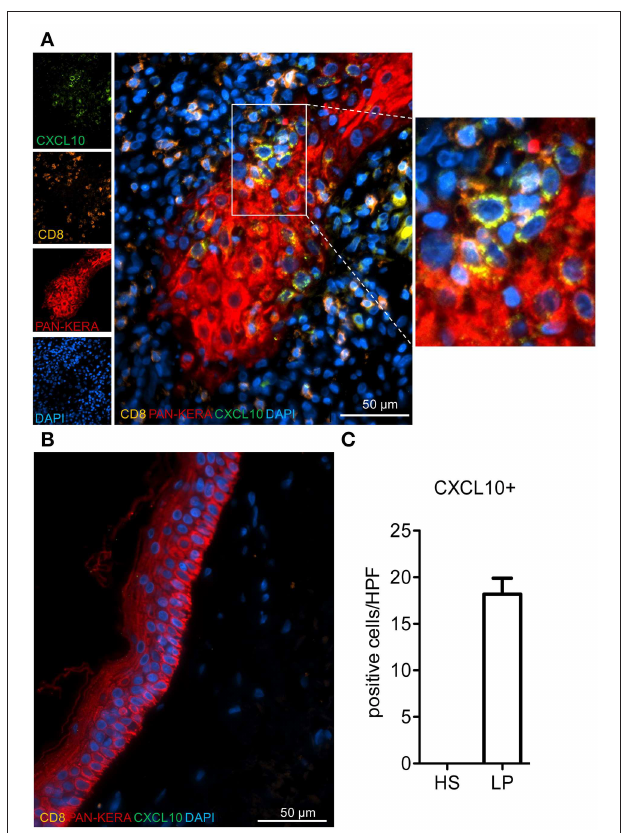
FIGURE 5 | Enumeration of selectively accentuated CXCL10 + keratinocytes in lichen planus patients. Representative immunofluorescence stainings for CXCL10, CD8, and pan-cytokeratin (Pan-Kera) in (A) lichen planus (LP) and (B) healthy skin (HS). Rectangle marks position of blow-up (right side). (C) CXCL10 + cells were counted in at least 3 high power fields (HPF)/patient ( n = 10) and compared to HS. Confocal microscopy, 40x magnification.